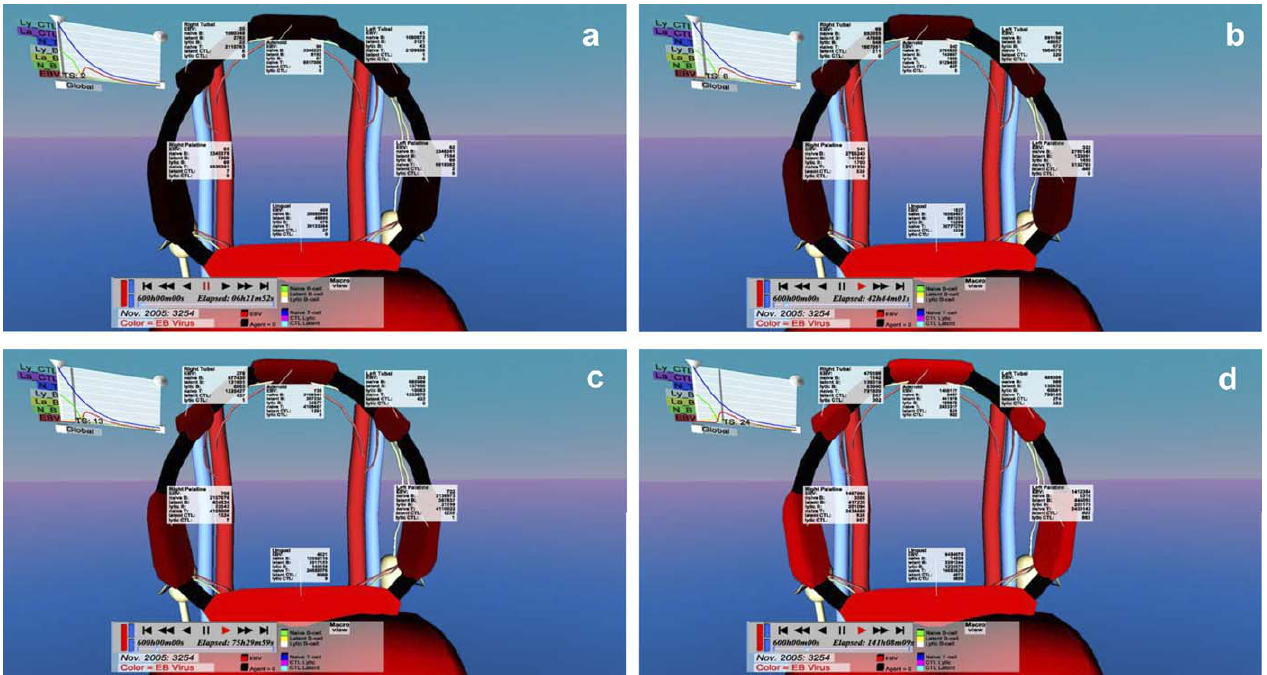
Figure 3. Progression of the Infection in a Typical Simulation as Visualized by the IRVE This Figure is similar to Figure 2E except that different time points in the infection process are shown. Vir were seeded evenly over the lingual tonsil and then allowed to spread to the rest of the ring. Note that in this case as time progresses (A–D) the infection spreads evenly to all of the other tonsils and adenoids as indicated by a gradual uniform increase of color intensity. These images are screen shots taken on 3/7/2007.